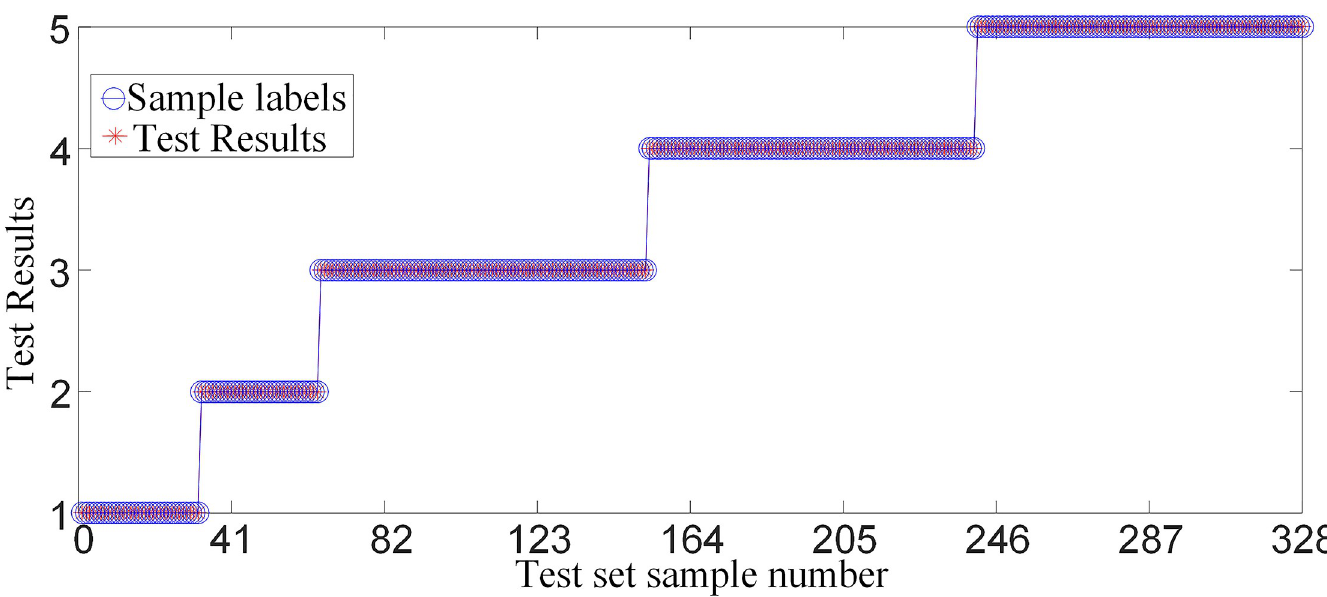
Fig 13. Comparison of test results when the training set is used as a test set.